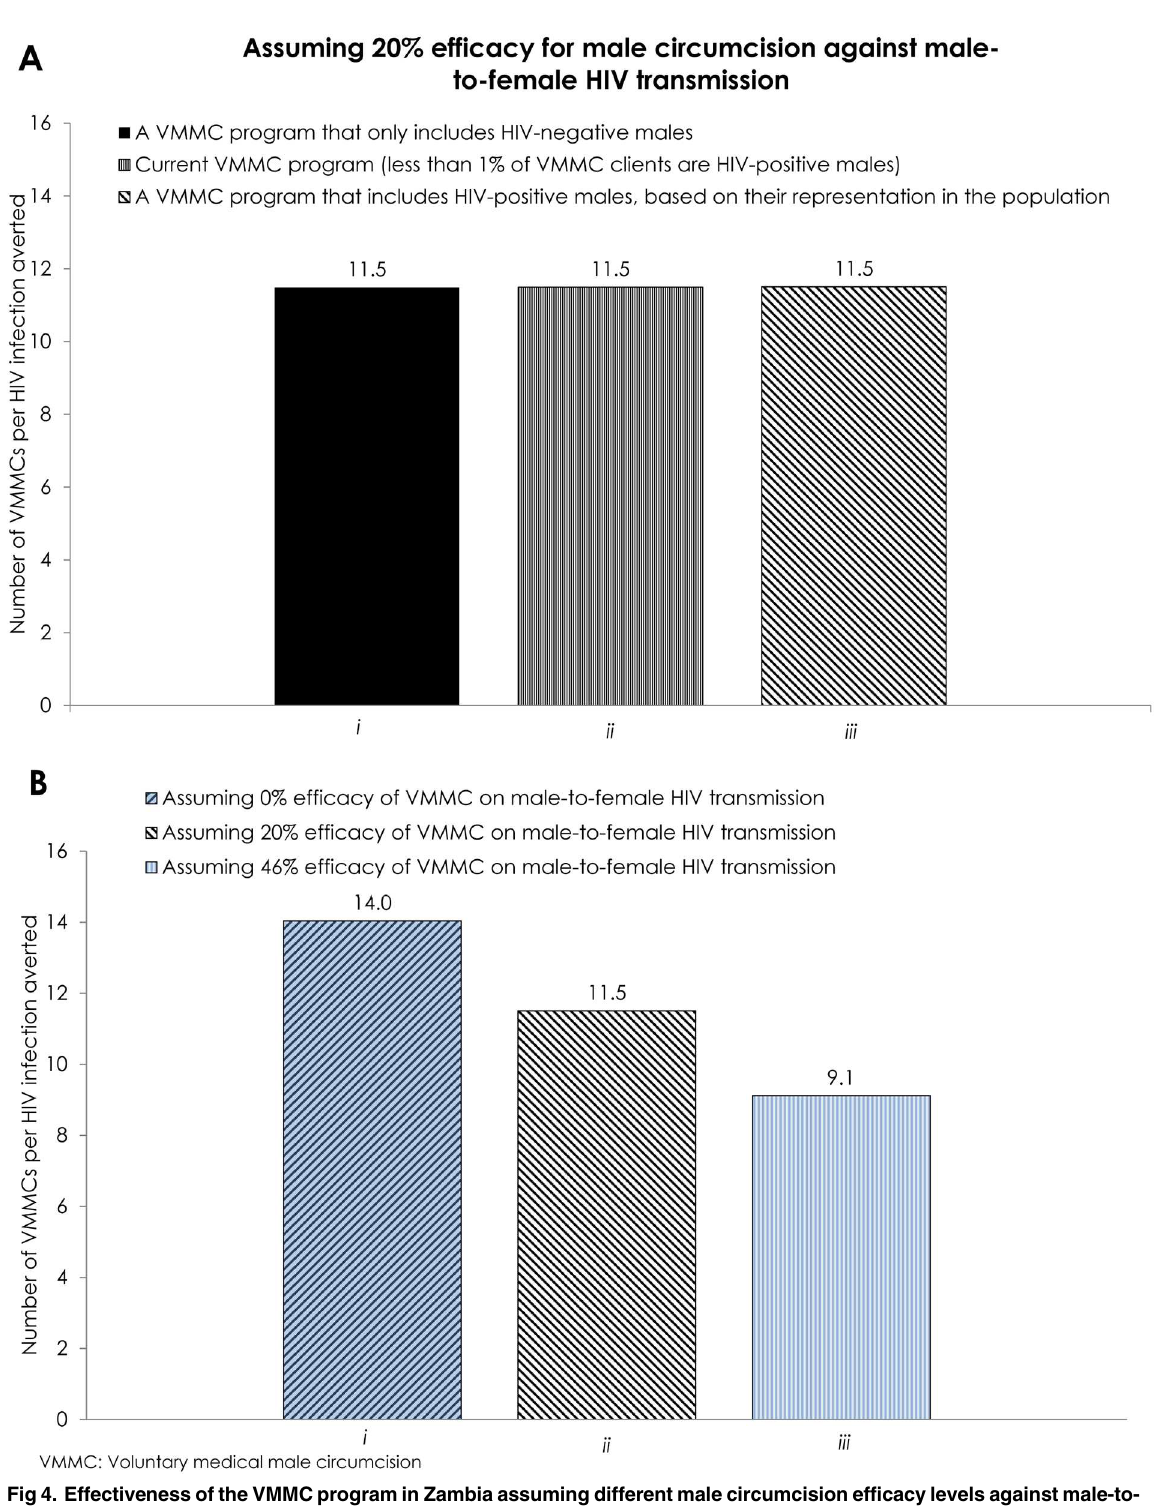
Fig 4. Effectiveness of the VMMC program in Zambia assuming different male circumcision efficacylevels against male-to- female HIV transmission. A) The panelshows the effectiveness of the VMMC program, assuming 20% efficacy for male circumcision against male-to-female HIV transmission, including i ) only HIV-negative males, ii ) HIV-positivemales as per current program data, and iii ) proportionof HIV-positivemales, based on their representation in the population. B) The panel shows the effectiveness of the VMMC program including a proportionof HIV-positivemales, basedon their representation in the population, but assuming i ) 0% efficacy, ii ) 20% efficacy, and iii ) 46% efficacy againstmale-to-female HIV transmission.Effectiveness is definedas the numberof VMMCs neededto avert one HIV